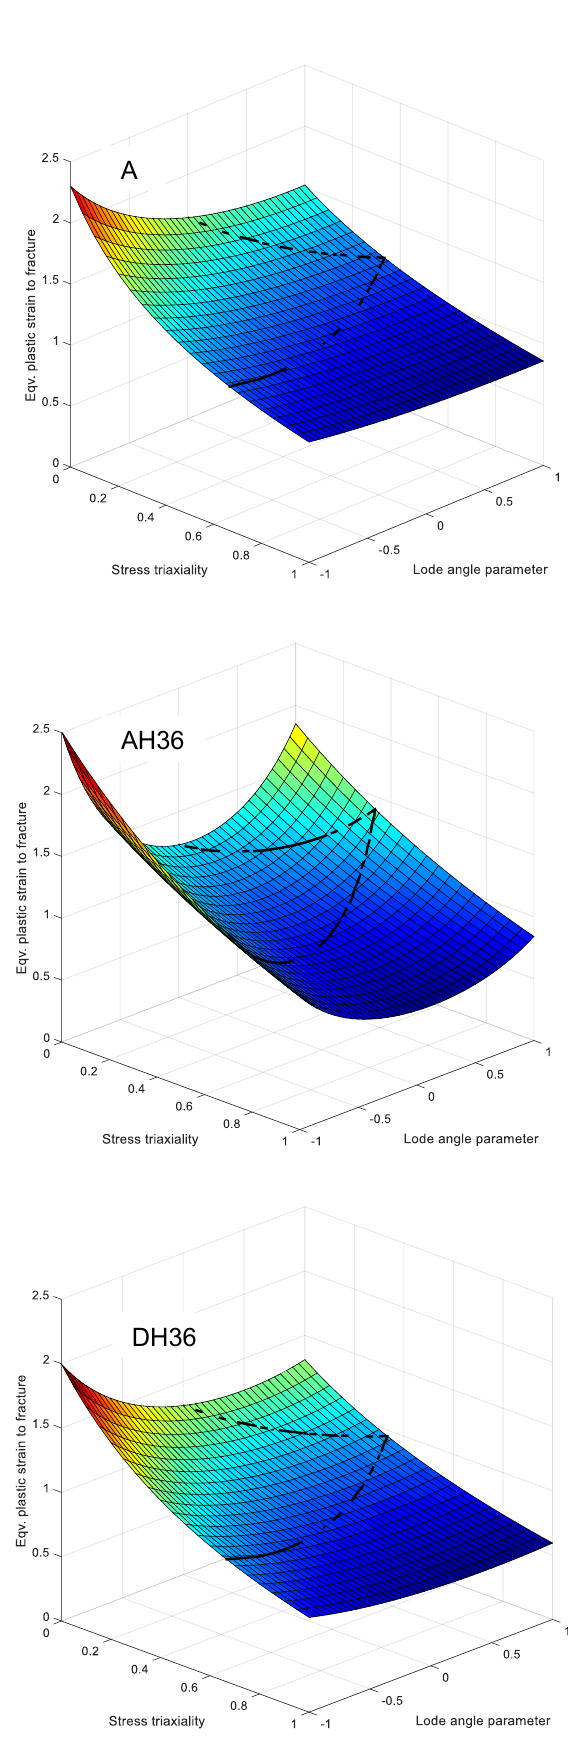
Figure 15. Calibrated 3D fracture loci of the steel grades